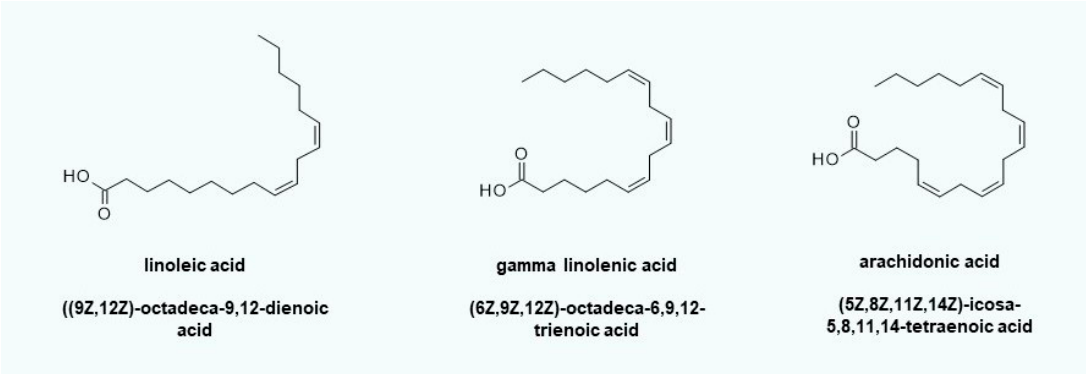
Figure 6. Fatty acids to protect the lysosomes and stabilize very long-chain ceramide de novo synthesis. Gamma-linolenic acid can be converted into dihomo-gamma-linolenic acid by elongation and subsequent oxidation to arachidonic acid by acyl lipid (8–3) desaturase. Arachidonic acid itself is a substrate of COX2 (PTGS2), which is inducible by oxidative stress. The resulting prostaglandin PGH2 and its derivatives can sensitize neurons. Linoleic acid first has to be converted into gamma linolenic acid by linoleoyl-CoA desaturase before it can be metabolized toward arachidonic acid. This can be a key advantage if itching or prostaglandin-mediated inflammatory reactions occur due to the application of creams containing gamma-linolenic acid.